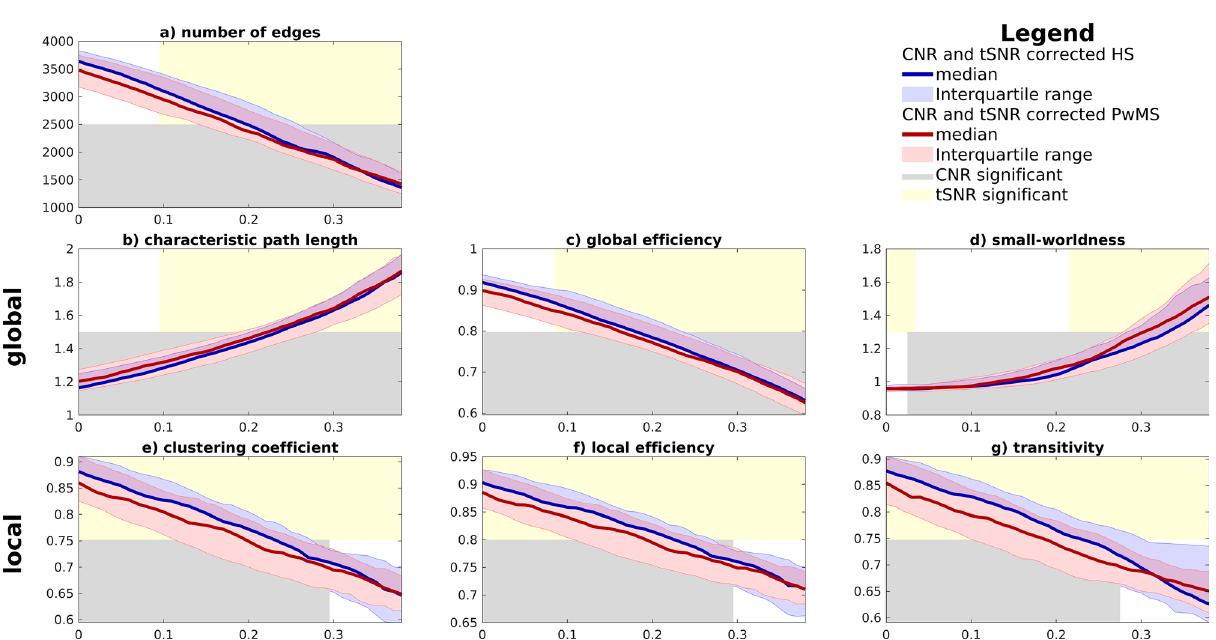
Figure 5. Graphs ( a ) to ( d ) show the global network parameters and e to g show the local network parameters. The median value and interquartile range of the GTA parameters, corrected for CNR and tSNR, are presented for PwMS (red) and HS (blue). The x-axis represents the thresholds from the adjacency matrix from which networks were extracted. The background is shown in grey and yellow for CNR and tSNR respectively to indicate at what thresholds they contributed